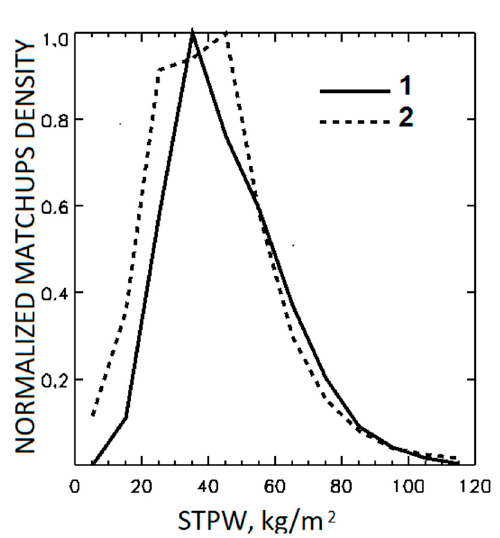
Figure 3. Normalized histograms in terms of total precipitable water vapor content along slant line of sight (STPW) of (1) matchups with in situ SSTs within TMDS-IS and (2) weighted matchups of nighttime ABI pixels with CMC L4 SSTs within the MDS-L4.